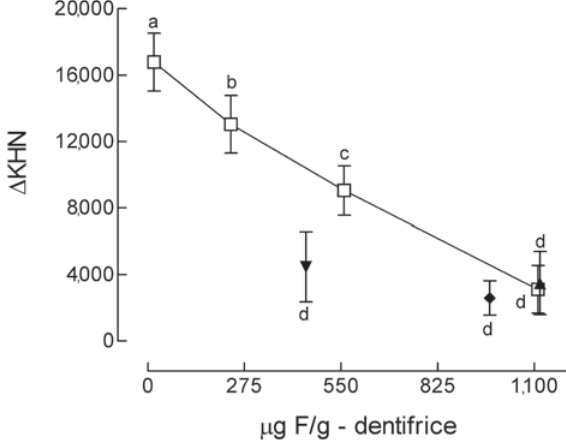
Figure 2- (cid:9) +(cid:6)=V(cid:8)#(cid:9) (cid:31)!(cid:8)(cid:6)(cid:3)"#(cid:7)(cid:6)(cid:3)(cid:4)(cid:6)(cid:20)(cid:4)(cid:9) (cid:4)(cid:8)$(cid:2)(cid:6)(cid:7)(cid:2)(cid:19)(cid:3)(cid:12)(cid:9) (cid:3)%(cid:29)(cid:23)&(cid:9) of integrated loss of subsurface hardness ( (cid:2) KHN) according to dentifrice. “ (cid:3) ” indicate dentifrice placebo, Z[(cid:22)(cid:30)(cid:9)(cid:22)(cid:22)(cid:23)(cid:9)(cid:6)(cid:3)(cid:4)(cid:9)(cid:29)(cid:30)(cid:29)(cid:23)(cid:23)(cid:9)(cid:24)(cid:25)(cid:9)(cid:26)(cid:27)(cid:25)(cid:12)(cid:9)(cid:13)(cid:16)(cid:15)(cid:9)(cid:2)(cid:3)(cid:4)(cid:2)(cid:5)(cid:6)(cid:7)(cid:8)(cid:9)Q(cid:20)(cid:8)#(cid:7)(cid:12)(cid:9)(cid:13)(cid:17)(cid:15)(cid:9)(cid:21)(cid:22)(cid:23)(cid:9)(cid:24)(cid:25)(cid:9) F/g; “ (cid:2) ” indicate 1,000 μg F/g. Distinct letters represent #(cid:7)(cid:6)(cid:7)(cid:2)#(cid:7)(cid:2)(cid:5)(cid:6)==>(cid:9)#(cid:2)(cid:25)(cid:3)(cid:2)T(cid:5)(cid:6)(cid:3)(cid:7)(cid:9)(cid:4)(cid:2)(cid:18)(cid:18)(cid:8)(cid:20)(cid:8)(cid:3)(cid:5)(cid:8)(cid:9)(cid:6)!(cid:19)(cid:3)(cid:25)(cid:9)(cid:25)(cid:20)(cid:19)V/#(cid:9)(cid:31)()*+((cid:12)(cid:9)